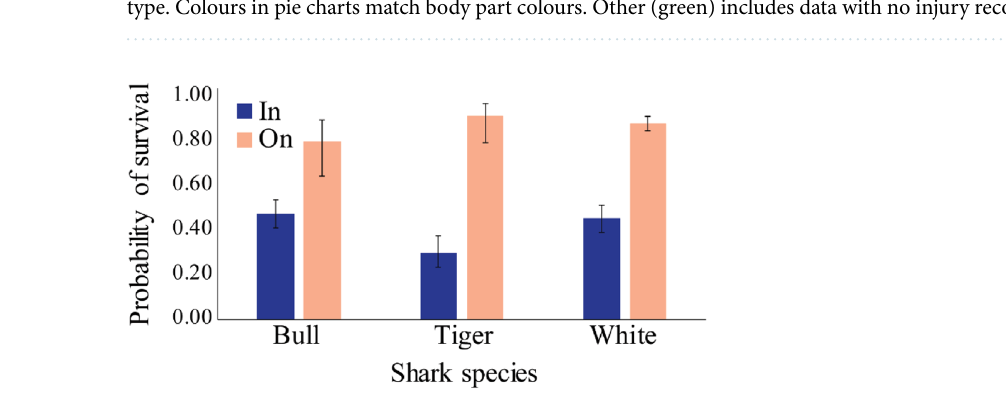
Figure 6. Survivability of shark bites for in water vs on water activities for bull, tiger and white sharks. On water activities include being on any unpowered vessel; surfing, bodyboard, kite board, kite surf, stand up paddle board, canoe, floatation device, kayak, rowboat, surf ski, wake boarding. In water activities include fishing (standing in water), free diving, SCUBA diving, snorkelling, standing/wading, swimming, swimming with unpowered vessel (e.g. clinging to